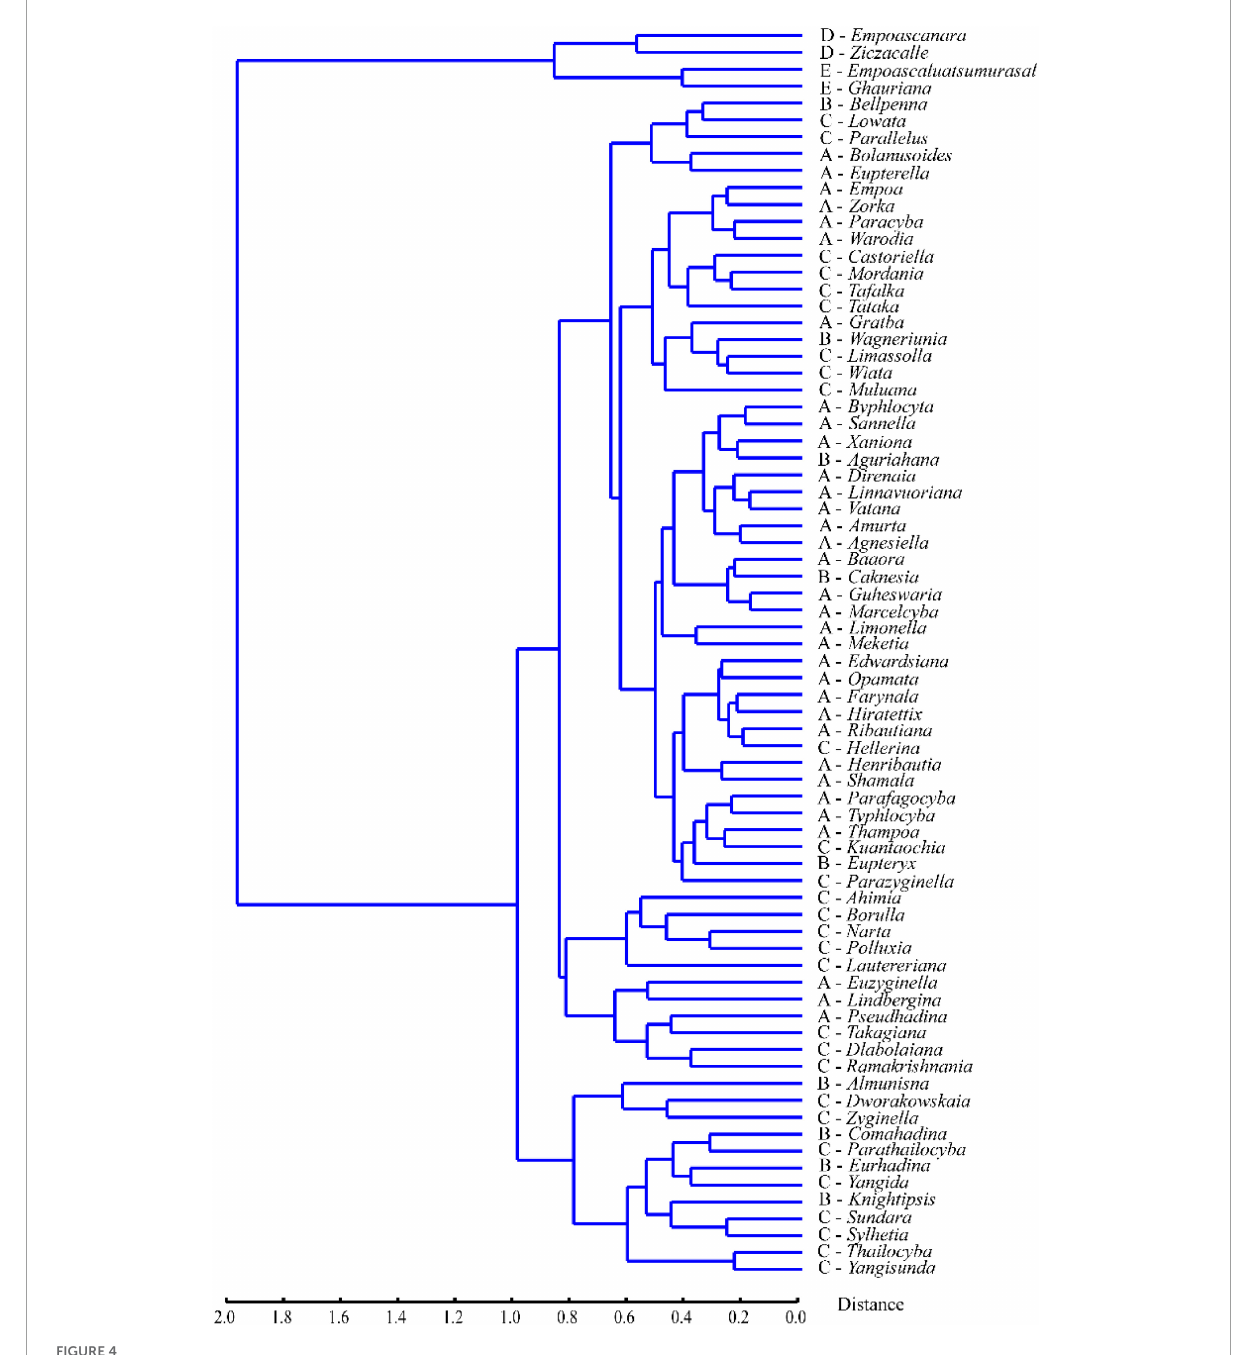
FIGURE4 Phenogram of the four tribes of Typhlocybinae based on unweighted pair-group method with arithmetic means (UPGMA) clustering of Procrustes distances.